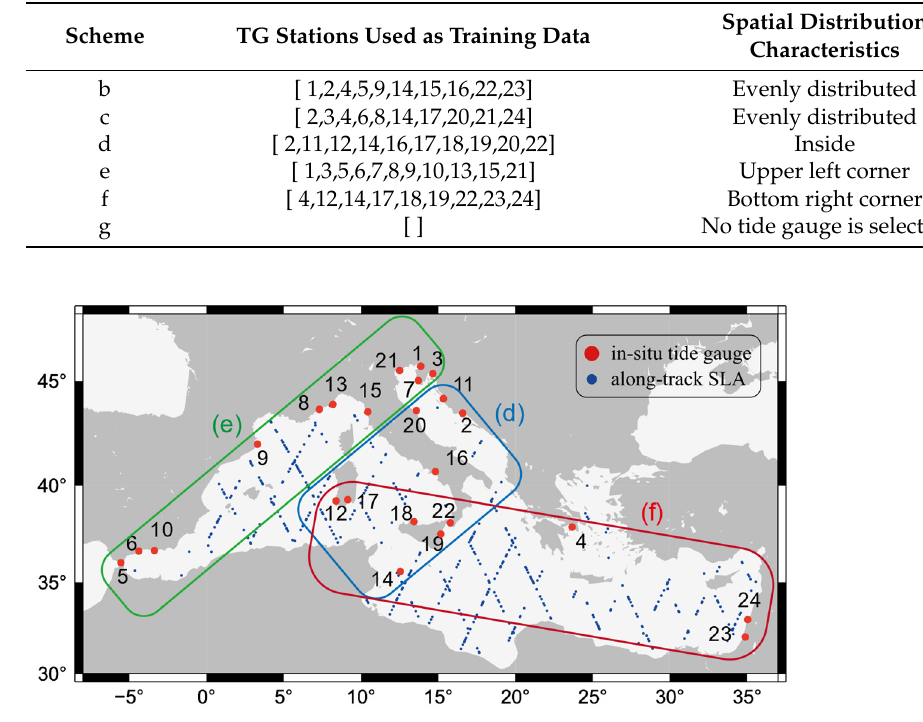
Figure 6. The distribution of in-situ tide gauges used as external control for different schemes and altimetry-derived along-track SLAs in training data. Scheme (b) is shown in Figure 5; scheme (c) in Table 3 is not shown; scheme (g) represents no tide gauge selected as external control. Table 1. Statistics of the four methods with altimetry-derived gridded SLAs in schemes (a) (m).